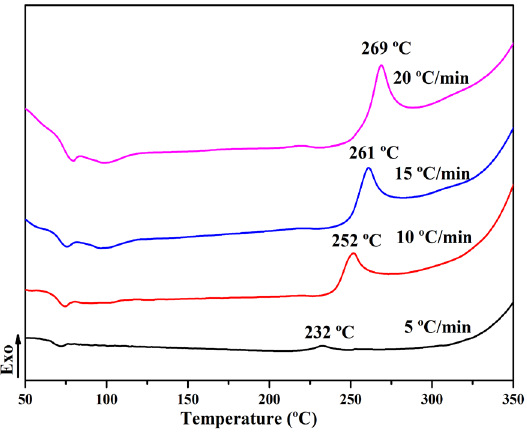
Figure 6. The DSC curves of BCPD/10 wt.% APPH at different heating rates.